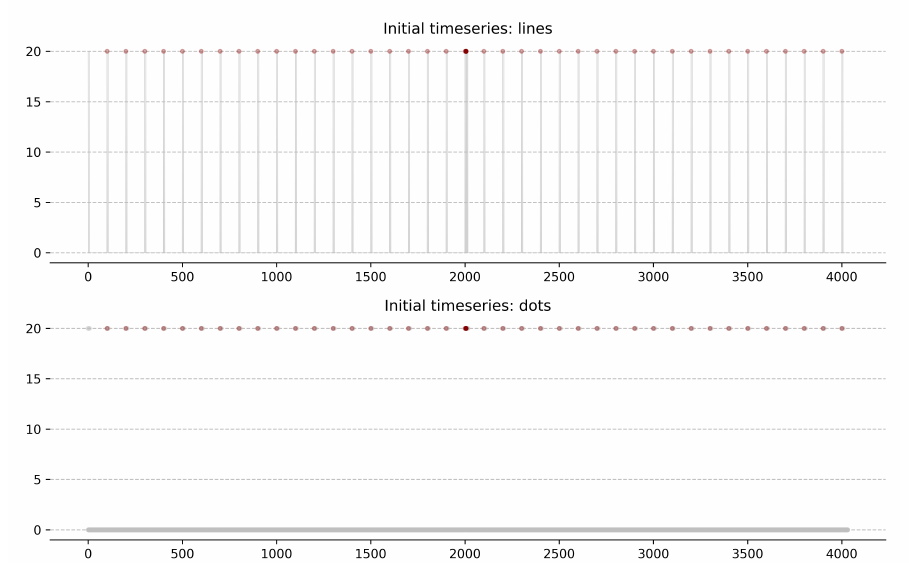
Figure 10. Numenta Anomaly Benchmark dataset spike density anomaly found with anomaly likelihood threshold 0.9.